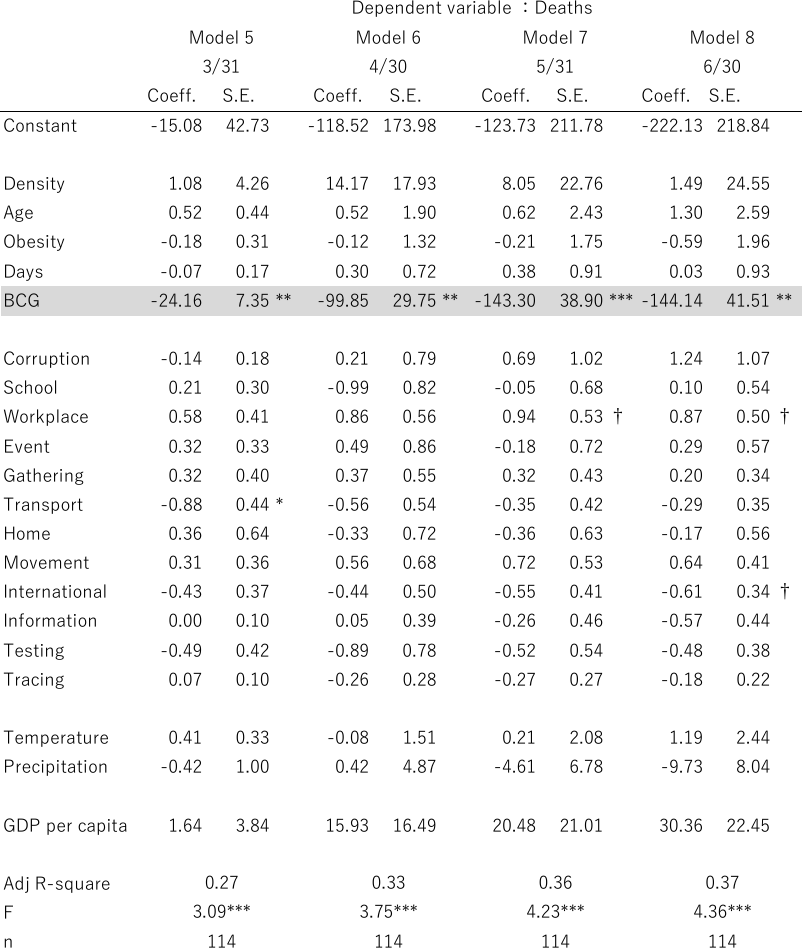
Table 2b. Results of multiple regression analyses (least-squares